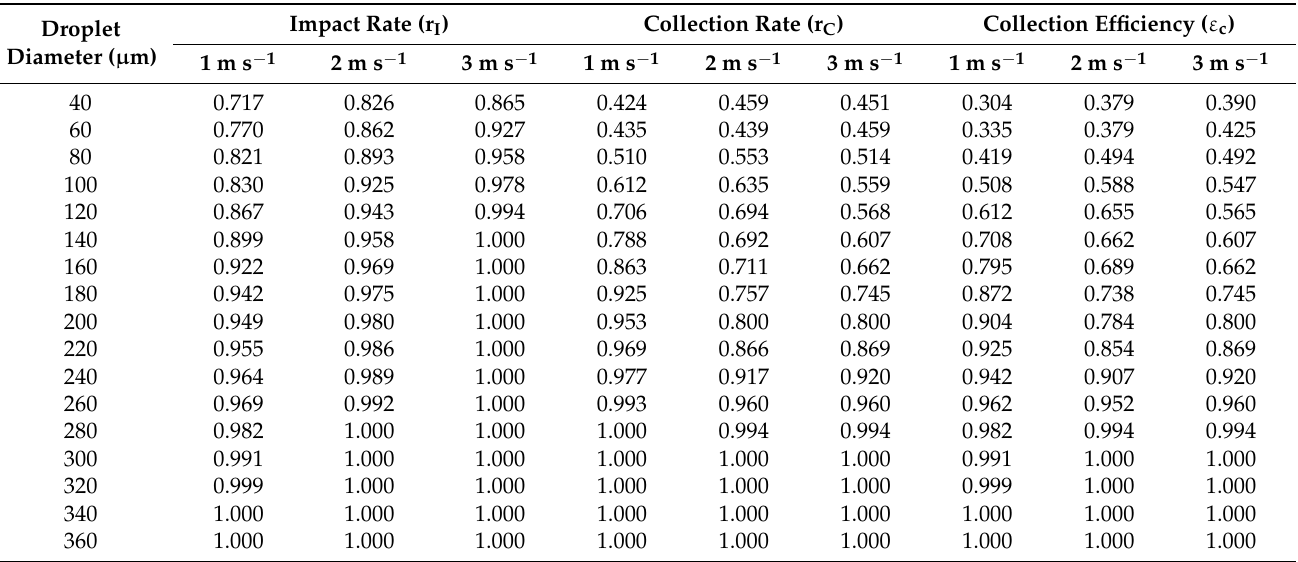
Table 3. CFD-computed impact rate, collection rate and collection efficiency according to wind speeds and droplet